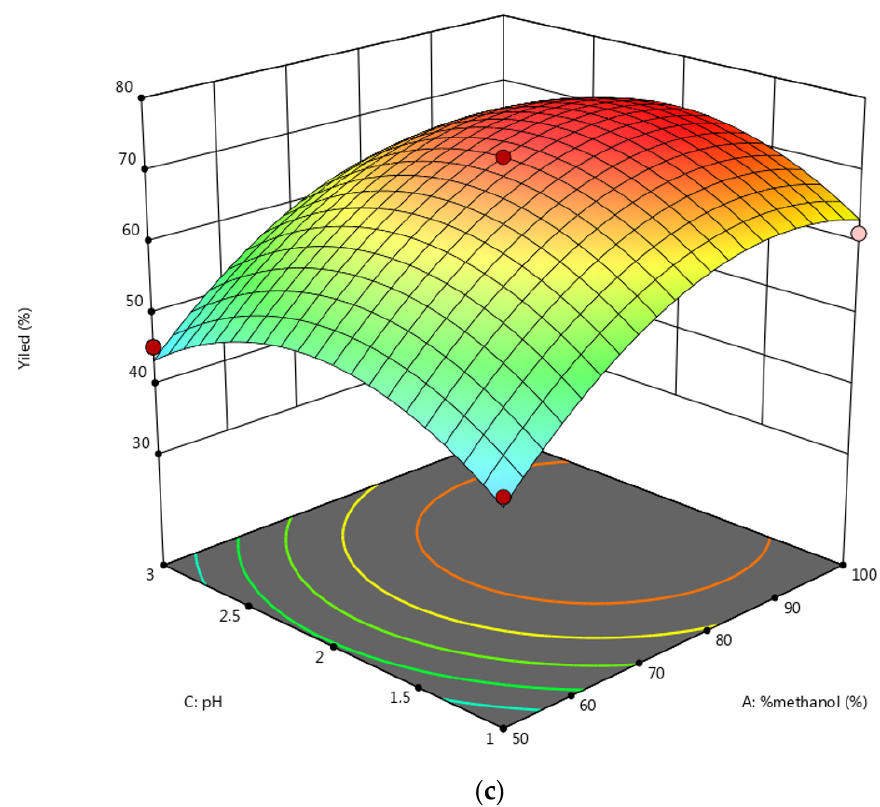
Figure 3. Three-dimensional (3D) response surface showing the interactions between ( a ) pH vs. volume, ( b ) volume vs. % methanol, and ( c ) pH vs. % methanol. Table 3. Phenolic compounds detected (mg/L) in different olive oil